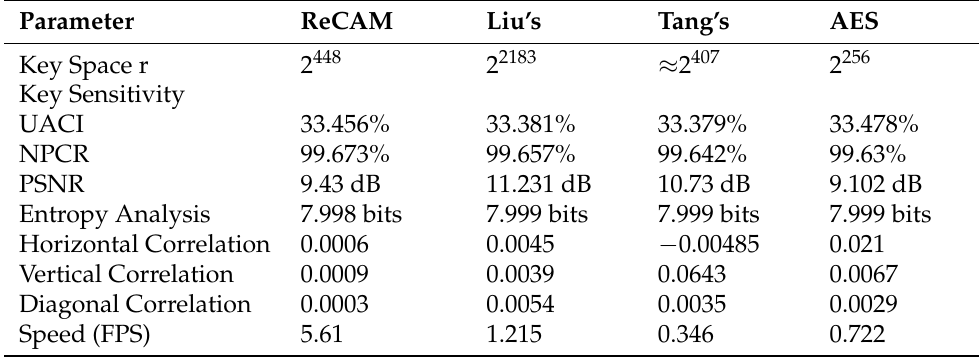
Table 6. Comparative security and performance